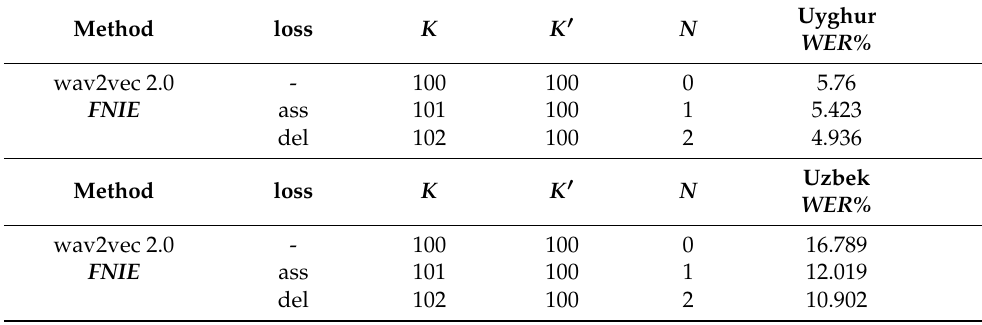
Table 5. Comparison of different